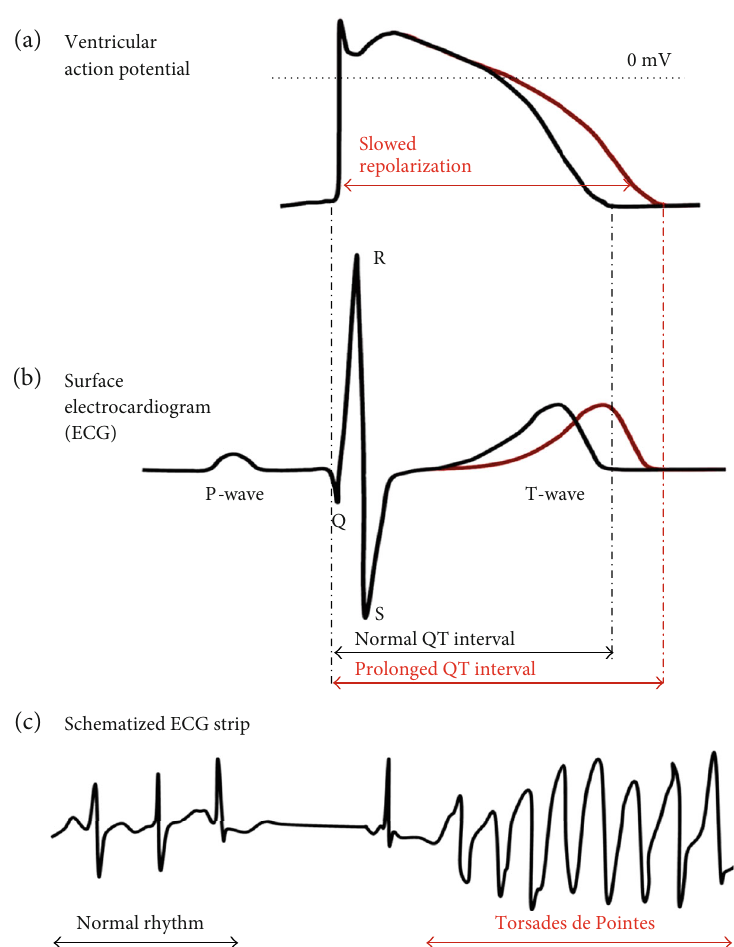
Figure 3: Schematic representation of ventricular action potentials and related ECG signals. (a, b) Normal and prolonged ventricular action potential and it related QT interval. (c) Schematic representation of ECG recording presenting the onset of Torsades de Pointes in a patient with long QT syndrome. Adapted from